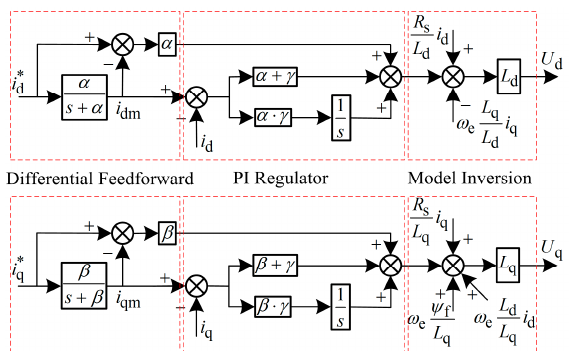
Figure 2. The traditional uncertainty and disturbance estimator (UDE)-based control without parameter tuning.